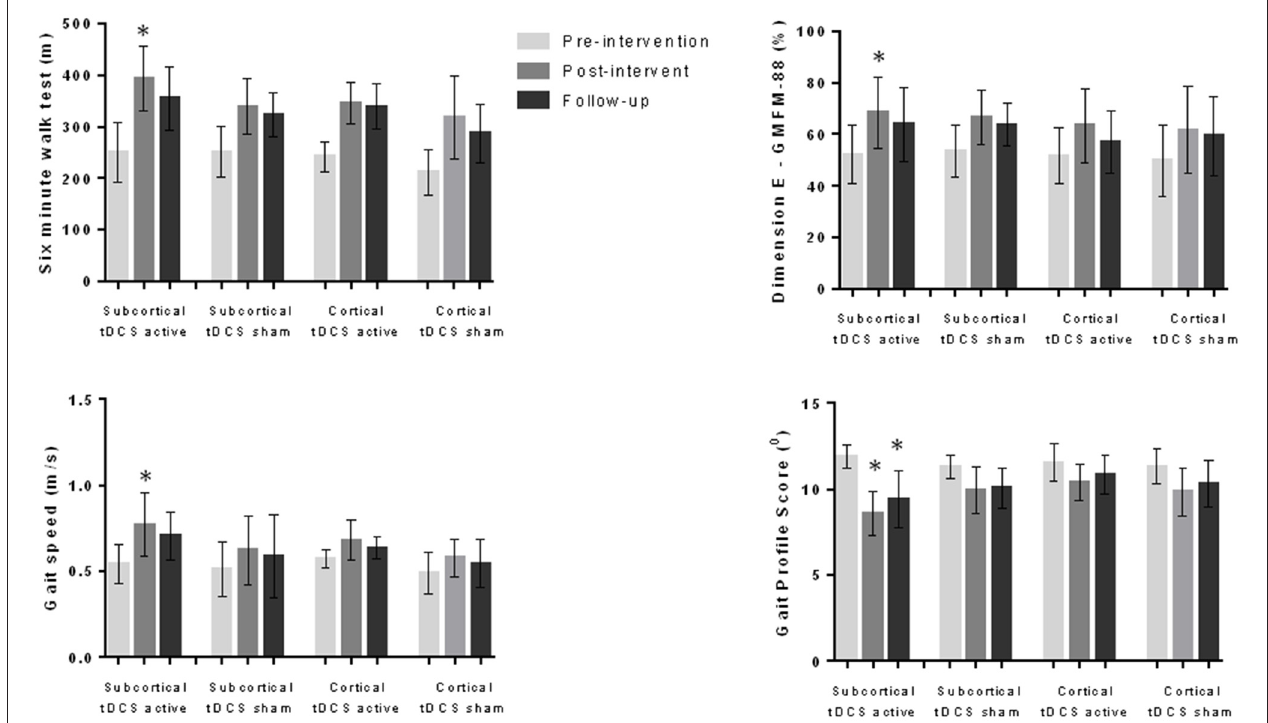
FIGURE 2 | Data for 6MWT, gait speed, gait profile score and dimension E of the GMFM-88 during pre-intervention, post-intervention and follow-up evaluations considering subcortical and cortical injuries as well as active and sham tDCS groups (56 children). Children with subcortical injury and who received active tDCS presented better results at the post-intervention evaluation in comparison to other groups for all variables. This group also had better results regarding gait profile score at follow-up evaluation. * p < 0.05 ANOVA followed by Bonferroni post hoc